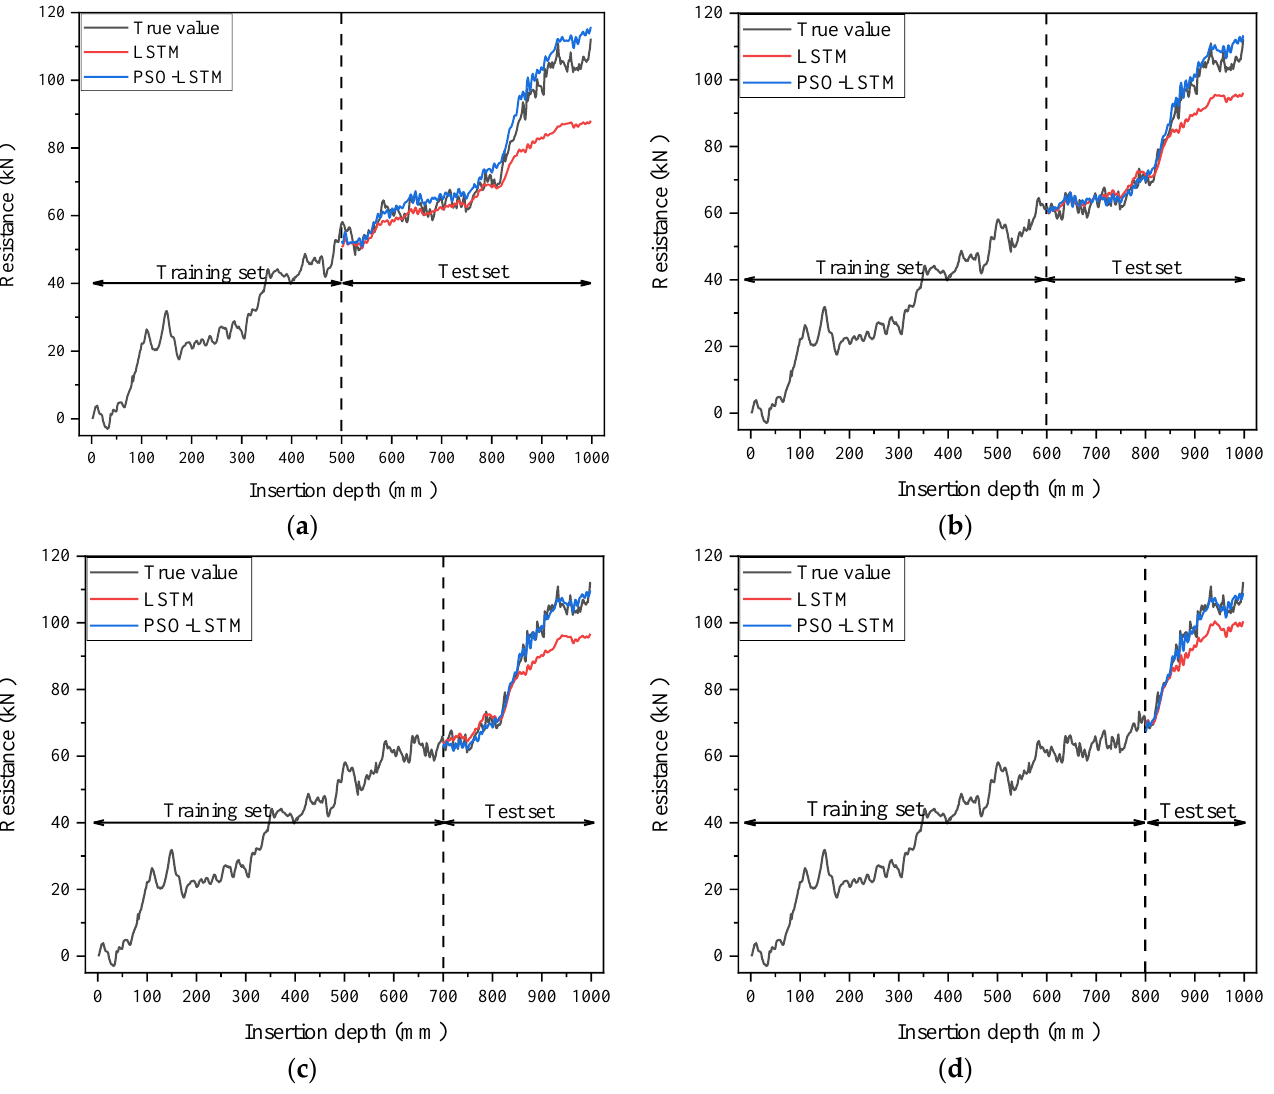
Figure 19. Gravel samples with an insertion depth of 1000 mm. ( a ) The training set proportion of 50%; ( b ) The training set proportion of 60%; ( c ) The training set proportion of 70%; ( d ) The training set proportion of 80%.